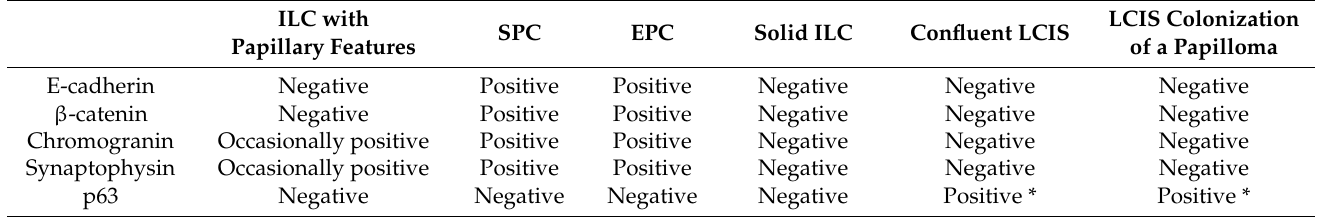
Table 7. Immunohistochemical characteristics of invasive lobular carcinoma with papillary features and its differential diagnoses.